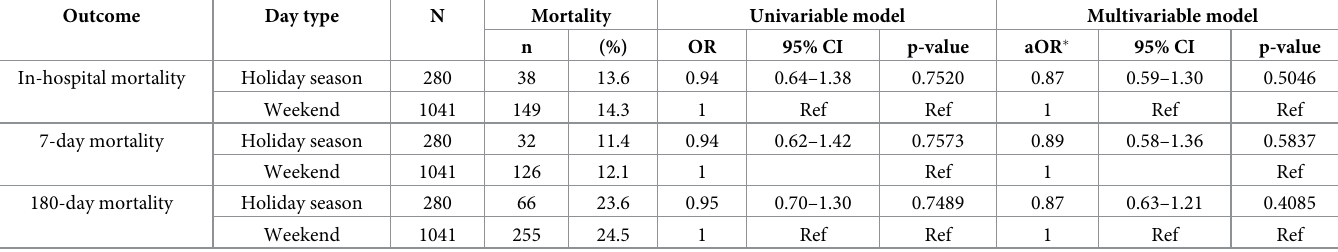
� The aOR is calculated by multivariable logistic regression model with adjustments for the characteristics listed in Table 1 (including age, sex, income level, aortic dissection type, hospital level, hospital area, Charlson comorbidity index score and comorbidities). Abbreviations: n, number; OR, odds ratio; aOR, adjusted odds ratio; CI, confidence interval; Ref, reference